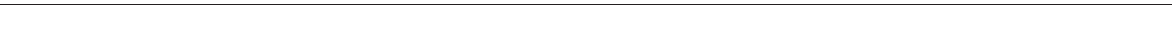
Fig. 3 A direct interaction between anillin and DIAPH3 enhances RhoA-mediated activation of DIAPH3 actin nucleation activity and the successful completion of cytokinesis. a MBP-anillin (1 – 151) , mutants, and wild type were incubated with GST-DIAPH3-NT, then the GST fusion proteins re-isolated on glutathione agarose beads and immunoblotted to detect and quantify the relative amount of co-purifying MBP-anillin mutants and wild type. n = 3. Error bars indicate ± s.e.m. * p = 0.0072, Student ’ s t test, comparing wt to RQPL 41 – 44 AAAA. b Pyrene-labeled actin nucleation assays in the presence of DIAPH3-CT-NT, GST-RhoA, and either 6× His-anillin wild type (1 – 151) or 6× His-anillin 4xA (41-RQPL-44 to AAAA). c Lysates from stable HeLa cell lines with a single integrated cDNA encoding GFP-anillin-wt (GFP-ANLN) or GFP-anillin 41-RQPL-44 to AAAA (GFP-4xA) under the control of the tet regulator were probed with an anti-anillin antibody. GFP fusion protein expression was induced by adding 1 μ g/ml doxycyclin (Dox). d GFP-anillin-wt (GFP-ANLN) and GFP-anillin-41-RQPL-44 to AAAA (GFP-4xA) were isolated from stable cell lines using a GFP-TRAP and co-purifying DIAPH3 detected by immunoblotting. e The number of binucleate cells, an indicator of cytokinetic failure, determined in the presence and absence of endogenous anillin, GFP-ANLN, or GFP-4xA. At least 100 cells were analyzed in each condition and in three experimental repeats. Error bars indicate ± s.e.m. * p = 0.002, ** p = 0.007, Student ’ s t test. f DIAPH3 localization in HeLa cells stably expressing either GFP-ANLN or GFP-4xA anillin treated with control or anillin siRNA. Blue is DAPI staining. Scale bar is 10 μ m. g Quantitation of endogenous DIAPH3 localization in the furrow region of a cell relative to the pole region of the cell. At least 100 cells were analyzed in each condition and in three experimental repeats. Error bars indicate ± s.e.m. * p = 0.007, ** p = 0.002 and *** p = 0.001, Student ’ s t